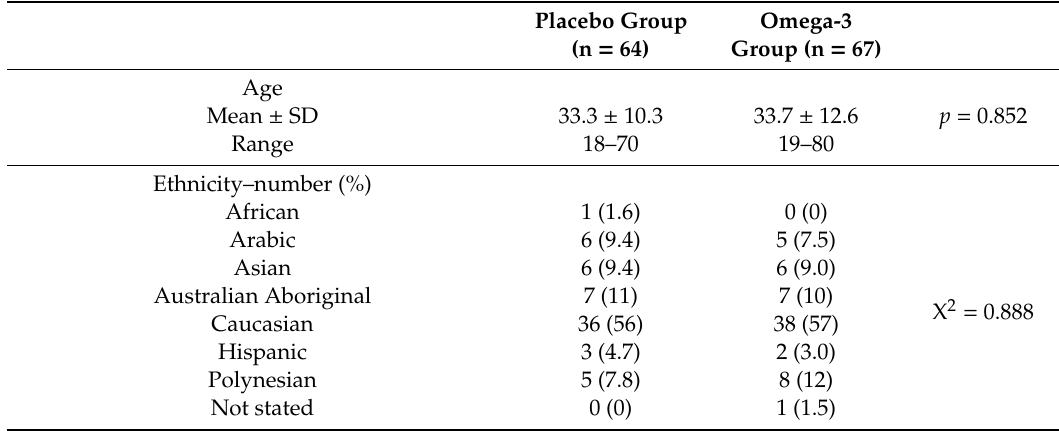
Table 3. Participant characteristics at